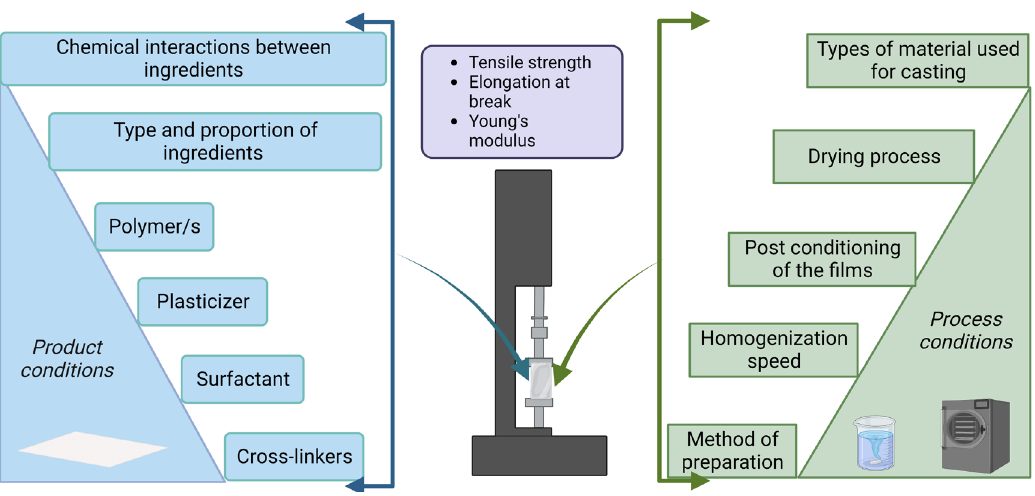
Figure 1. Different factors affecting the mechanical properties of the edible films.